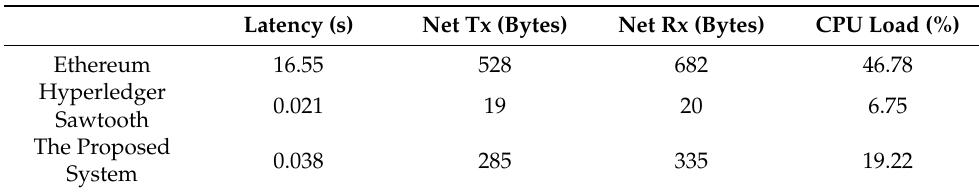
Table 4. Benchmark of performance